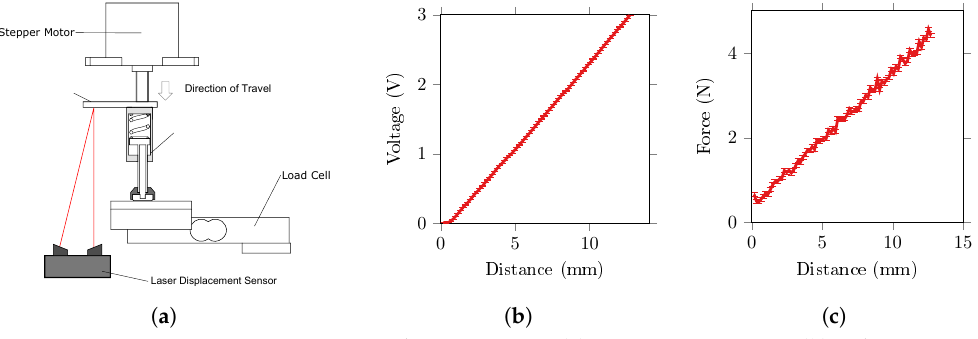
Figure 9. Spring return position sensor characterisation ( a ) measurement setup ( b ) voltage across compression mean ± std ( c ) force measured during compression mean ±